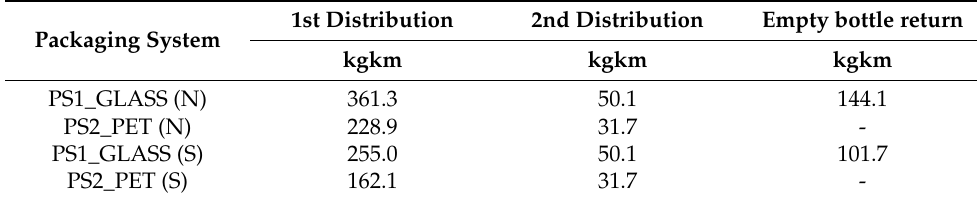
Table 4. Main primary data of the distribution phase. The data are normalized in function of the FU of the